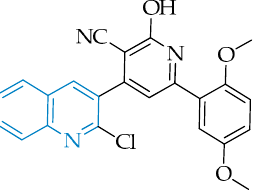
Figure 2. Structural representation of the antitoxoplasmic candidate PPQ-8.